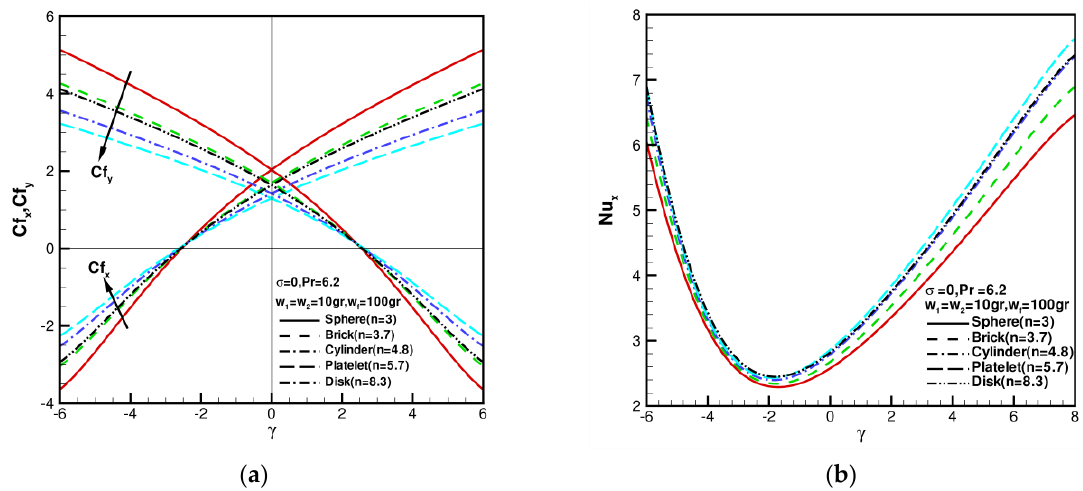
Figure 6. Skin friction coefficients Cf x , Cf y and local Nusselt number Nu x against γ , shape factor n when w 1 = w 2 = 10 gr, w f = 100 gr, σ = 0, and Pr = 6.2: ( a ) the distributions of Cf x , Cf y ; ( b ) the distributions of Nu x